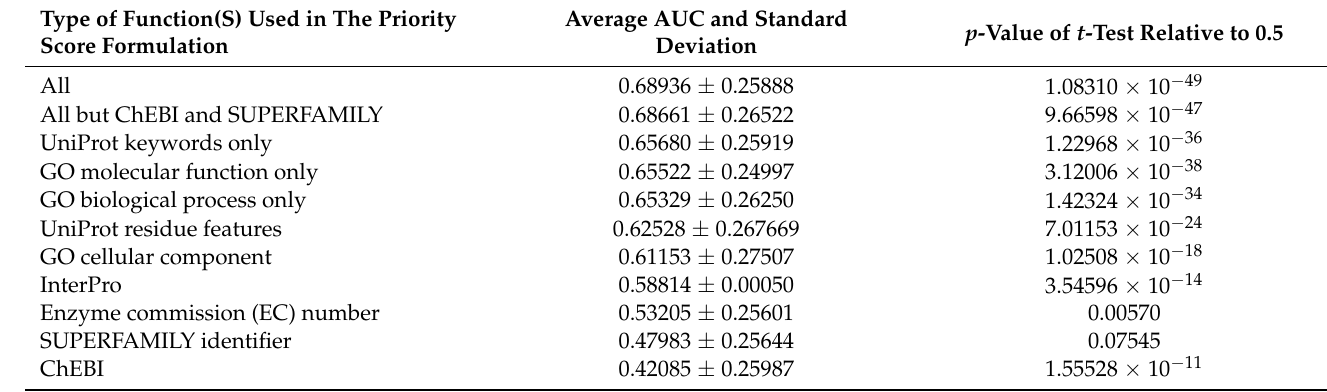
Table 1. Area under the curve (AUC) values for the retrieval of known targets of the queried diseases. The positives are proteins known to be targeted by medications currently used to treat the disease. The negative comparison set is represented by proteins of the protein–disease dataset that are not known to be targeted by a medication used to treat the disease. The average AUC value per analysis was determined by obtaining the mean AUC when using the 513 diseases of the validation